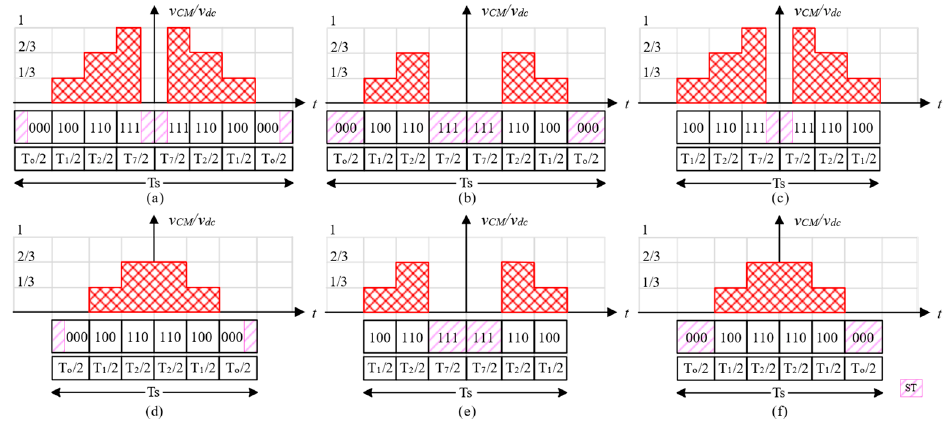
Figure 9. CMV waveforms during a carrier wave. ( a ) 3 Φ /SB/SPWM, ( b ) 3 Φ /MB/SPWM, ( c ) 3 Φ /SB/+DCCM, ( d ) 3 Φ /SB/-DCCM, ( e ) 3 Φ /MB/+DCCM, and ( f ) 3 Φ /MB/-DCCM